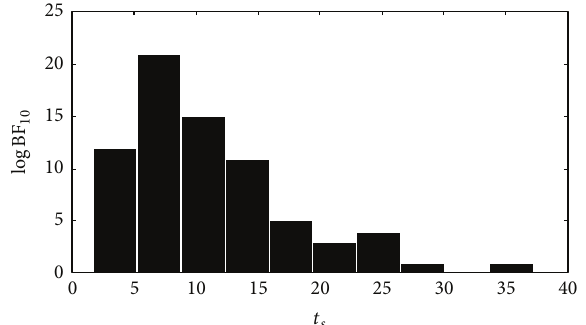
Figure 5: Comparison with the predictions for survival rate (solid line) and the actual values (dashed